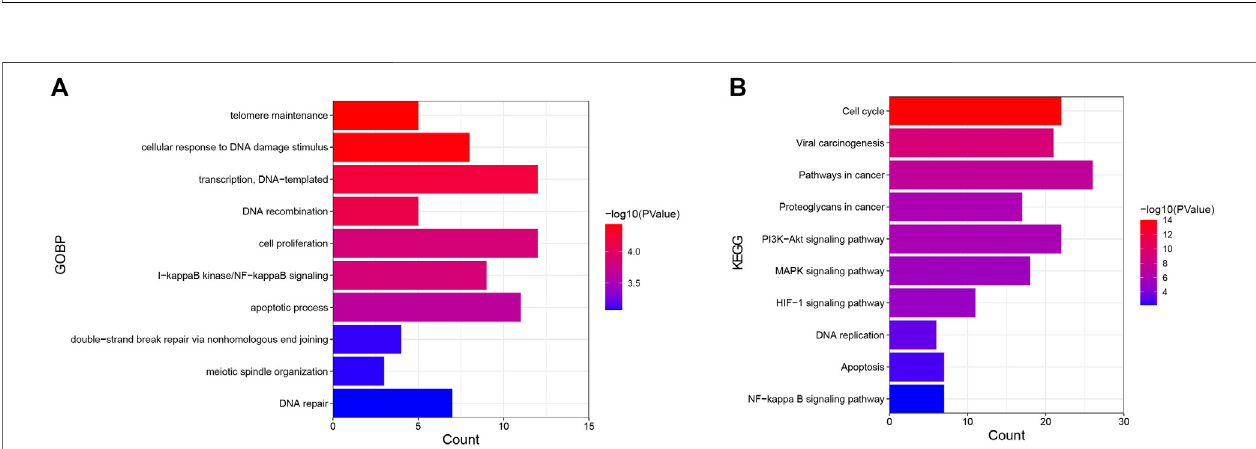
FIGURE 3 | GO and KEGG analyses of targets of celastrol involved in its therapeutic effect on ovarian cancer. (A) GO analysis. The Y -axis shows the enriched GO items of target genes. The X -axis shows the gene counts for the items. The color indicates the p value. (B) KEGG analysis. The Y -axis shows the enriched KEGG pathways for target genes. The X -axis shows the gene counts for the items. The color indicates the p value.